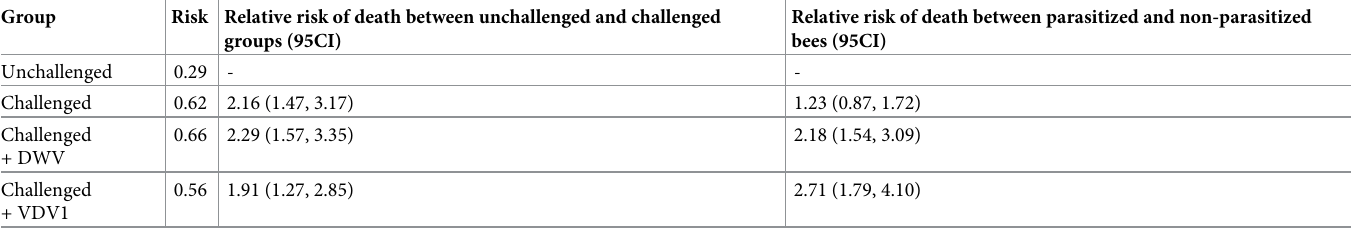
Table 3. Relative risk of death between and within groups. Risk and relative risk table Risk reported for bees within their own group (column 2). Relative risk estimates with confidence intervals reported between challenged groups to the unchallenged control (column 3). Relative risk estimates between parasitized and non-parasitized individuals within their own group (column 4).